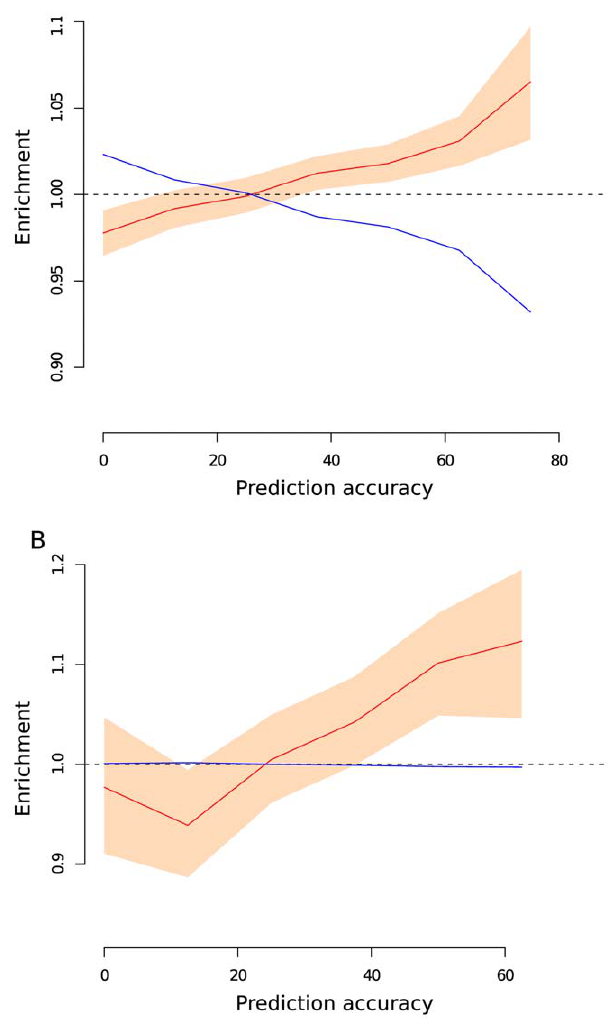
Figure 1. Enrichment of SNPs for different values of prediction accuracy. Enrichment of genic (red line, panel A) or non-synonymous (red line, panel B) vs. intergenic SNPs (blue line, both panel) for different values of prediction accuracy. Peach region denotes 90 th confidence interval computed with 1,000 bootstrap resamplings on overlapping blocks of 40 contiguous